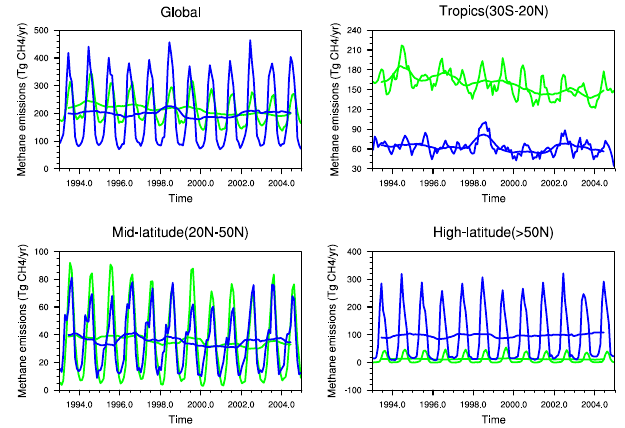
Figure 5. Temporal variation of wetland CH 4 fluxes estimated in CN_a (green) and BGC (blue). The globe is divided into three re- gions: the tropics (30 ◦ S to 20 ◦ N), mid-latitudes (20–50 ◦ N), and high latitudes (>50 ◦ N). Please note that this is the original methane emissions produced by CN_a and BGC without any multiplication. The smooth green and blue lines indicate the 12-month average wet- land CH 4 fluxes for CN_a and